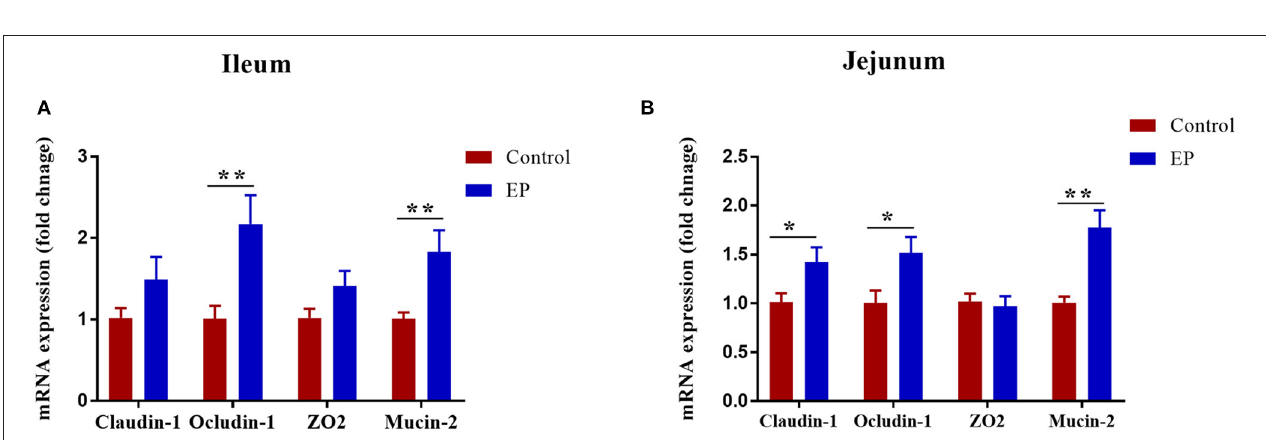
FIGURE 4 | Effects of EP supplementation on Mucin-2 and tight junction gene expression in the ileum (A) and jejunum (B) tissues of broiler chickens. Data are presented as mean ± SEM, n = 10. * P < 0.05 and ** P < 0.01, respectively.